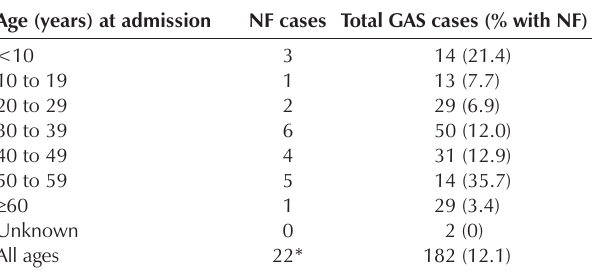
Risk factors and/or precipitating events as related to injection drug use Risk factor and/or Injection Injection drug precipitating event